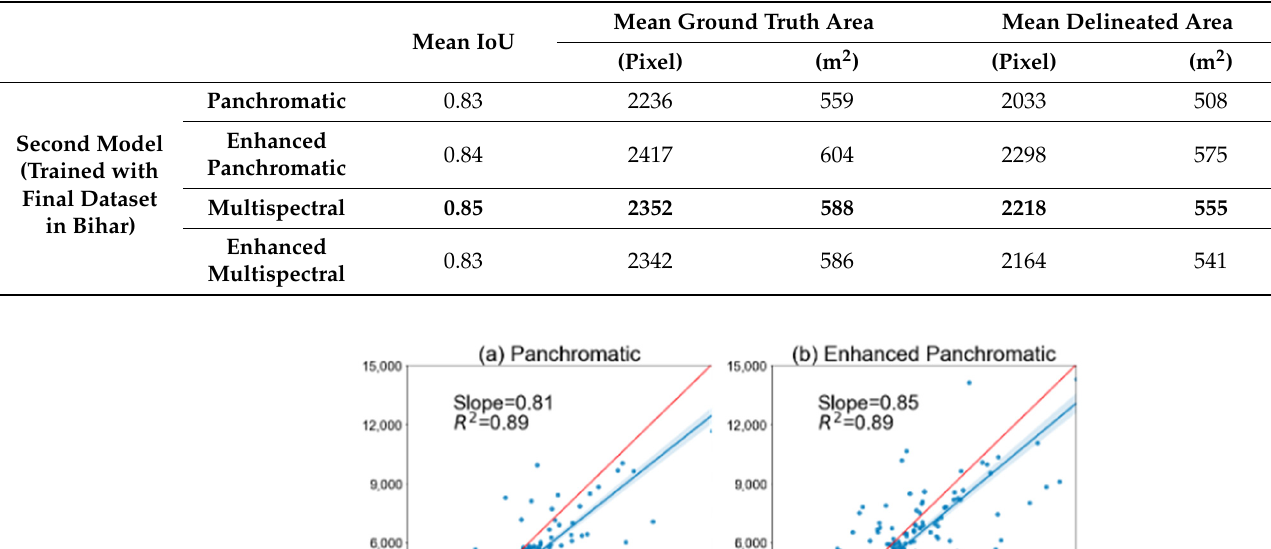
Table 8. Mean IoU, mean ground truth area, and mean delineated field area in Uttar Pradesh from models trained using WV-3 data in Bihar. Only correctly delineated field masks were included in the generation of this table. The areas are reported in terms of both the number of pixels and square meters (rounded to the nearest integer). The metrics from the model with the best IoU are shown in bold.